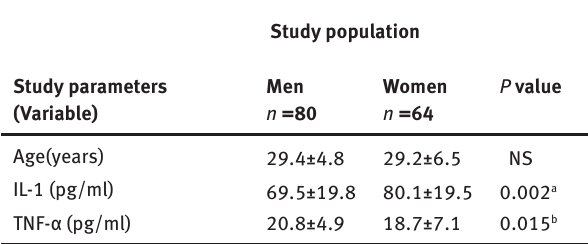
Table 1: Descriptive data stratified by gender